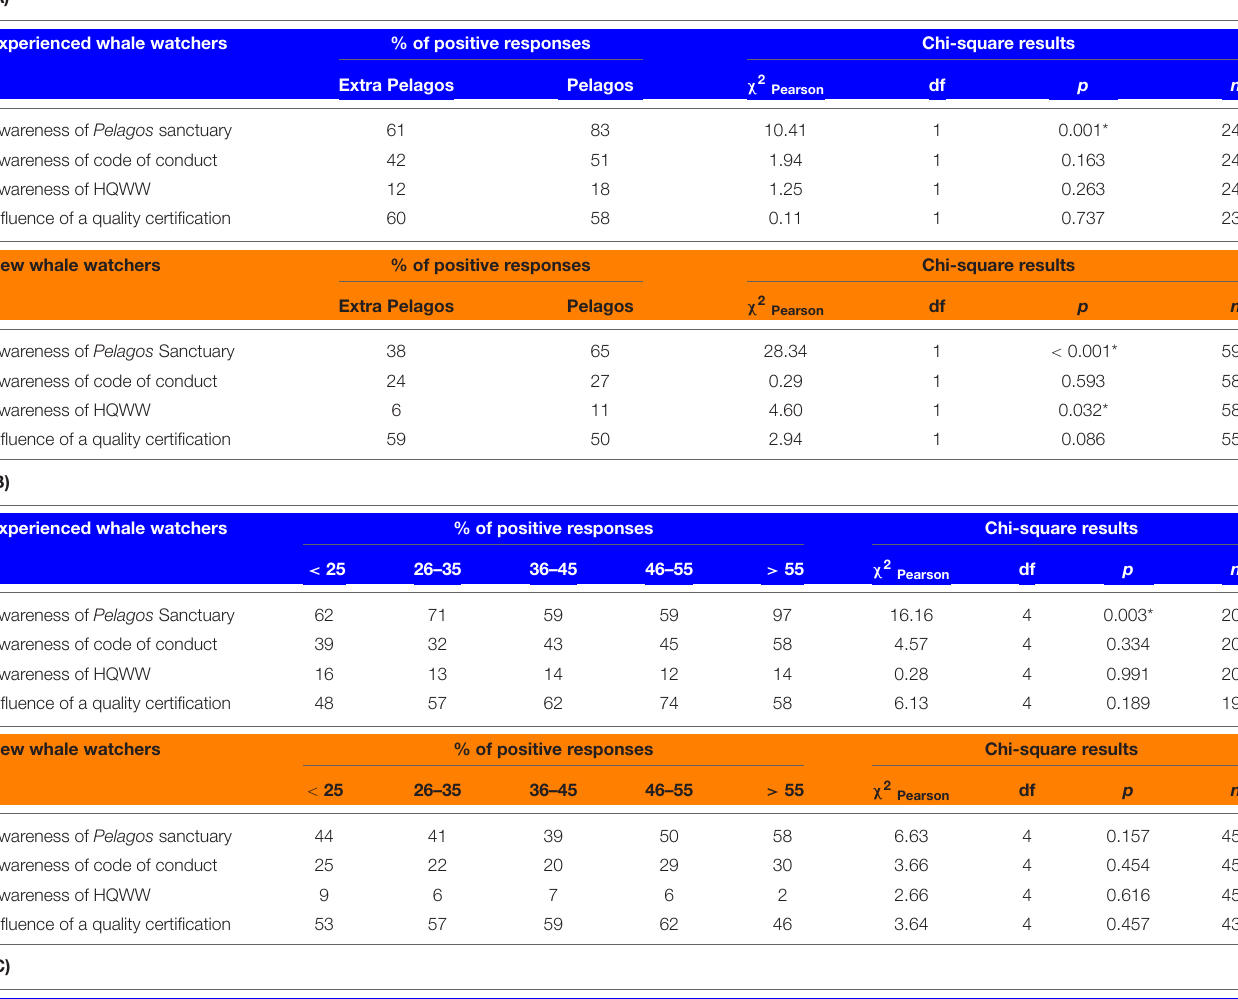
TABLE 2 | Awareness of the existence of Pelagos Sanctuary, Code of Good conduct for approaching cetaceans, HQWW R (cid:13) and influence of the presence of a label in the choice of operator, separately for Experienced (blue) and New (orange) and for the sub-groups considering origin (A), age class (B), and education level